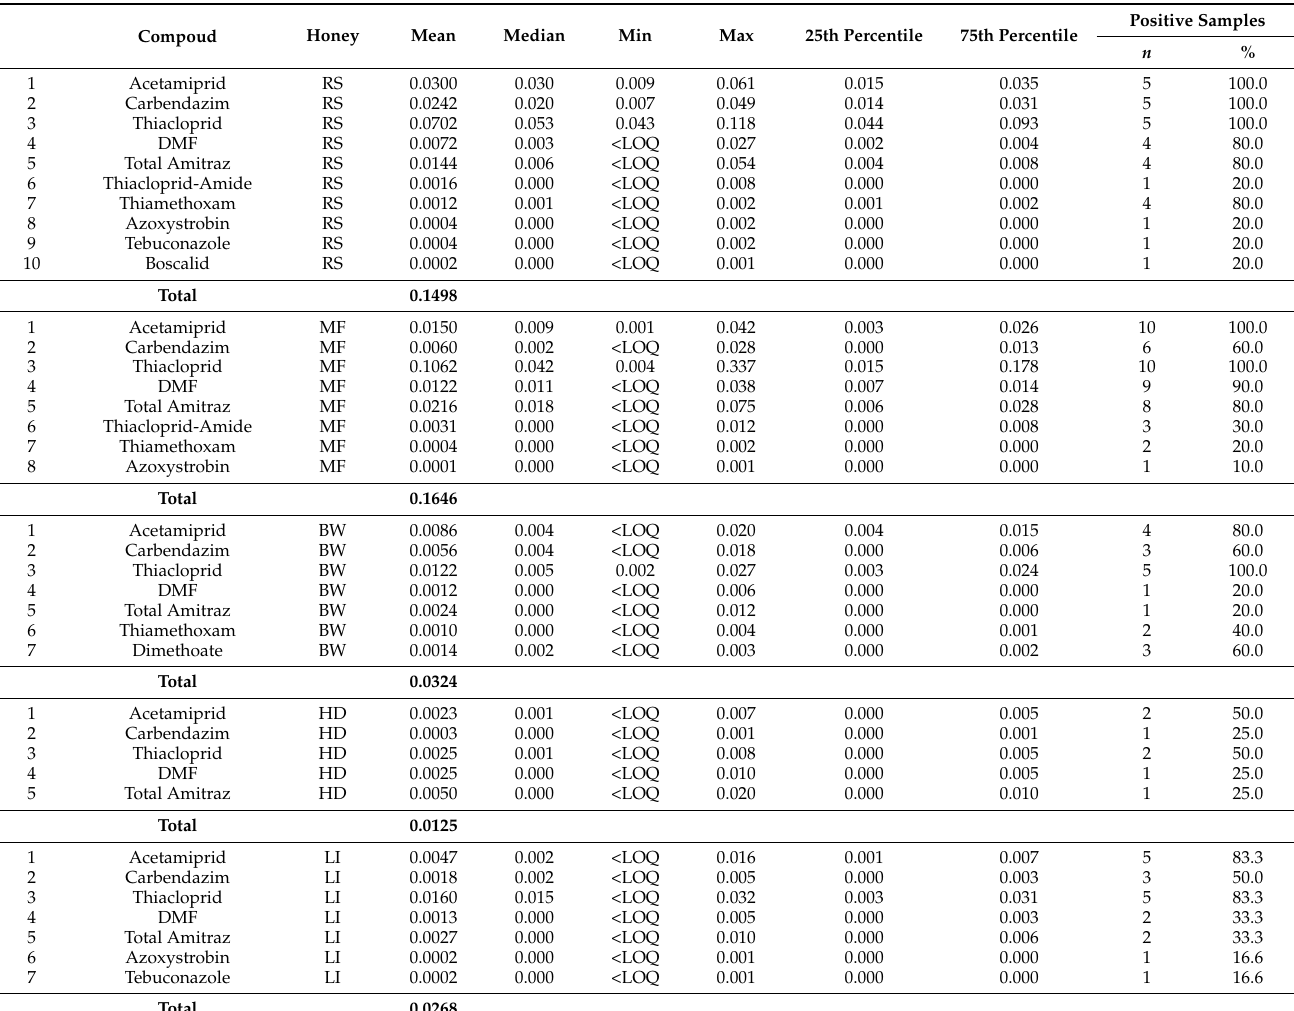
Table 4. Descriptive statistics of pesticide residues (mg/kg) detected in varietal honeys